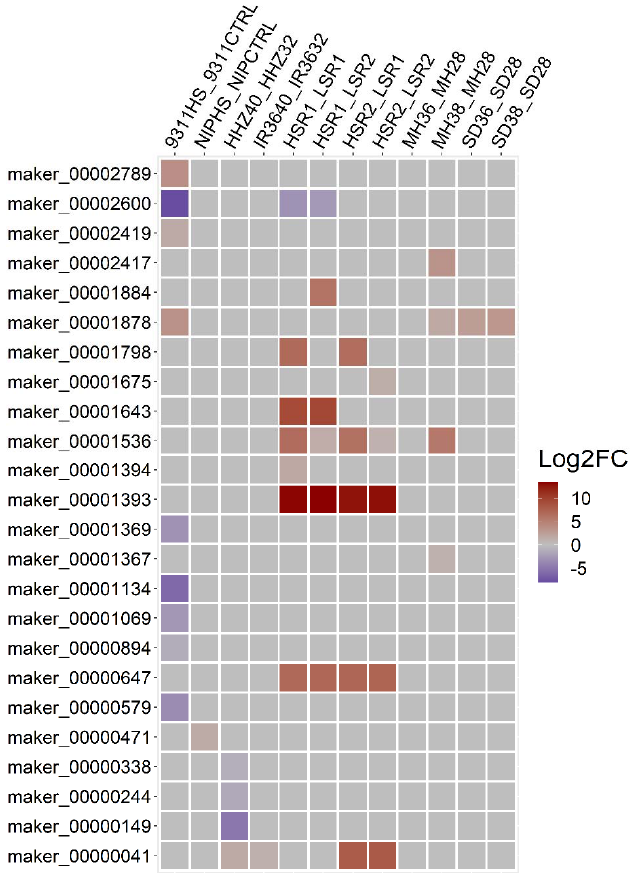
Figure 5. A Venn diagram plot of the genes with heat tolerance-related SNPs (GENES_WITH_HS_SNPs) compared to the upregulated and downregulated genes in the 4 RNA-seq datasets.